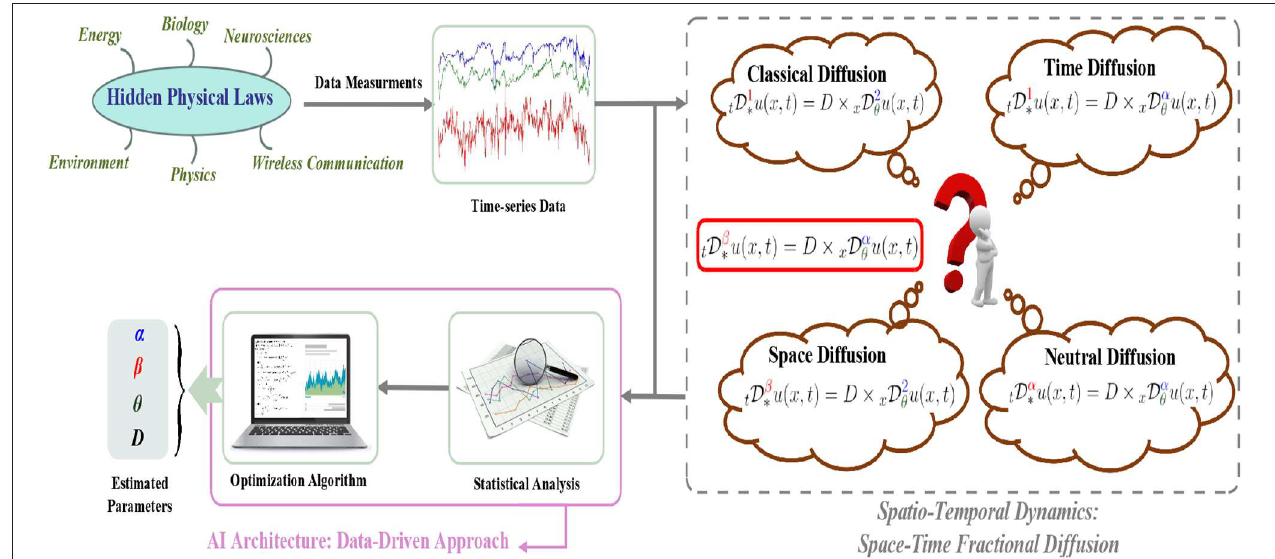
FIGURE 1 | Flowchart showing an AI architecture used to uncover hidden patterns governing complex phenomena: a data-driven based approach to estimate the parameters of the space-time fractional diffusion equation from spatiotemporal